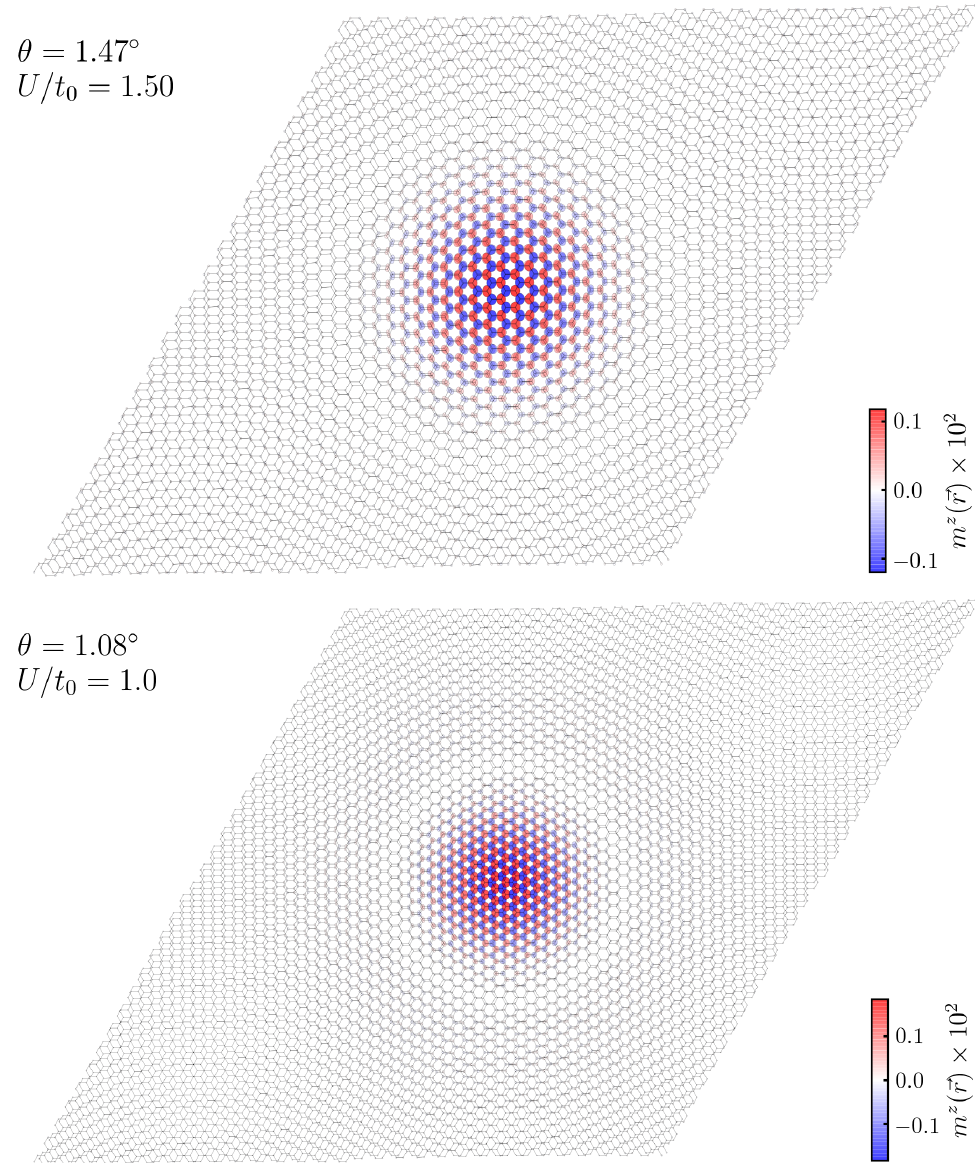
Figure 6: The top and bottom panels show the spatial magnetization profile of non- scaled systems at θ = 1.47 ◦ and θ = 1.08 ◦ , respectively. The corresponding numbers = 6076 and N = of atoms in the unit cell are N c c